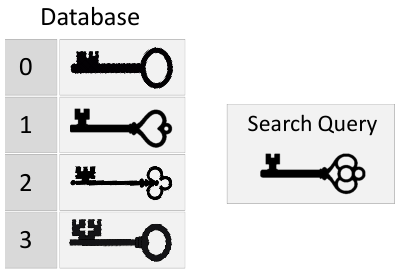
Figure 1. Simple example of associative